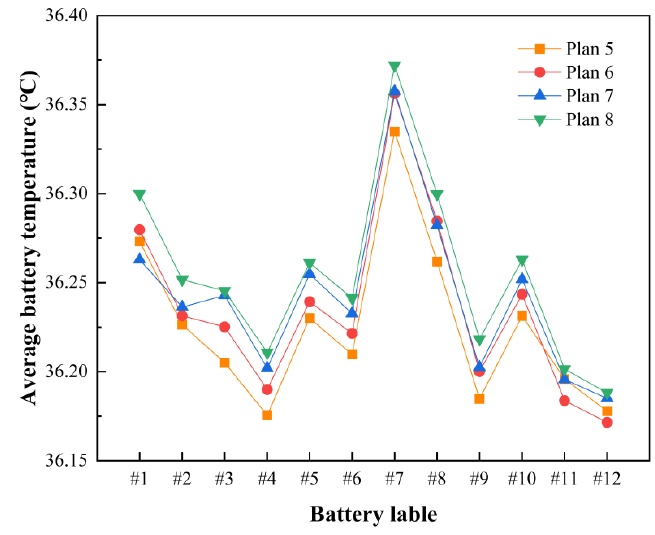
Figure 11. Average cell temperature under different distributions.